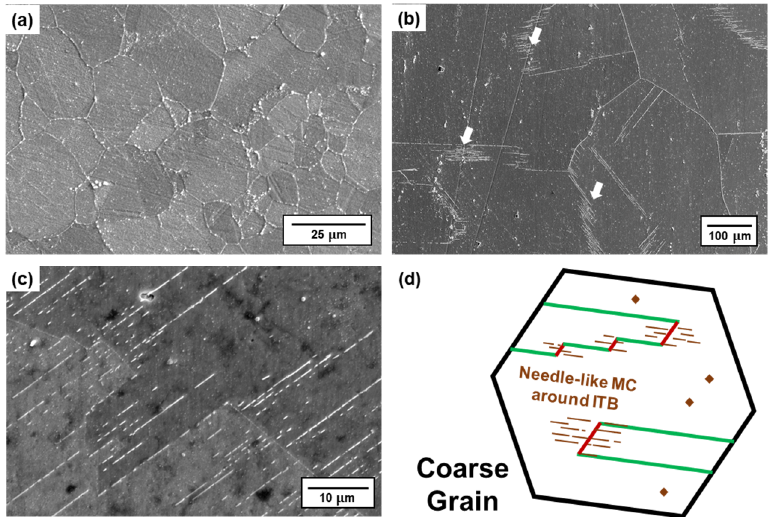
Figure 2. SEM images of ( a ) FG-A and ( b ) CG-A specimens. The white arrows indicate needle-like MC carbides around incoherent twin boundary (ITB). ( c ) The magnified image showing needle-like MC carbides in CG-A specimen. ( d ) Schematic image of the microstructure of CG-A specimen.